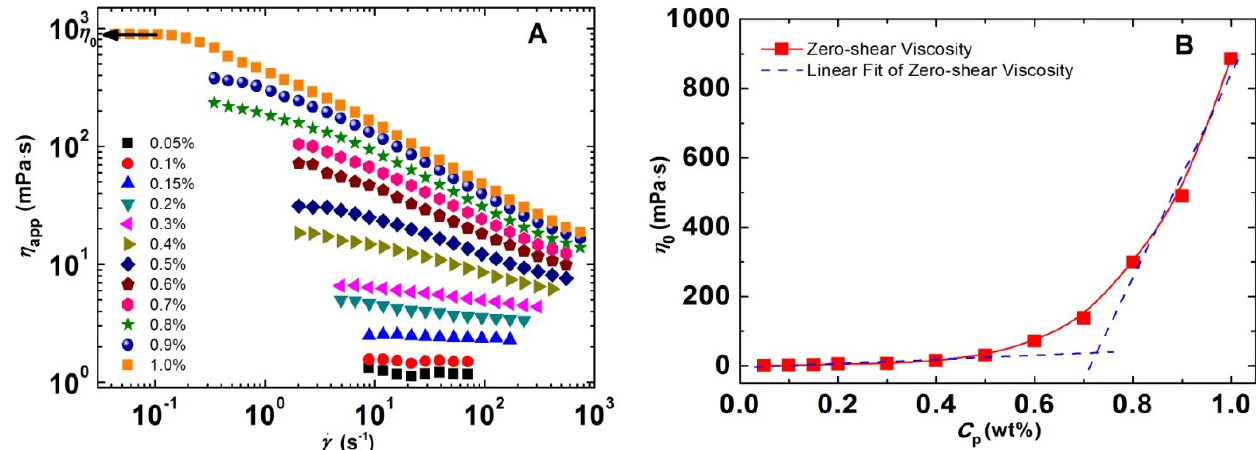
Figure 1. ( A ) Apparent viscosity plotted as a function of shear rate for various concentrations of HAHPAM and ( B ) zero-shear viscosity ( η ) plotted as a function of polymer concentration 0 for HAHPAM in brine (TDS = 32,868 mg∙L −1 , [Ca 2+ ] + [Mg 2+ ] = 873 mg∙L −1 , T = 85